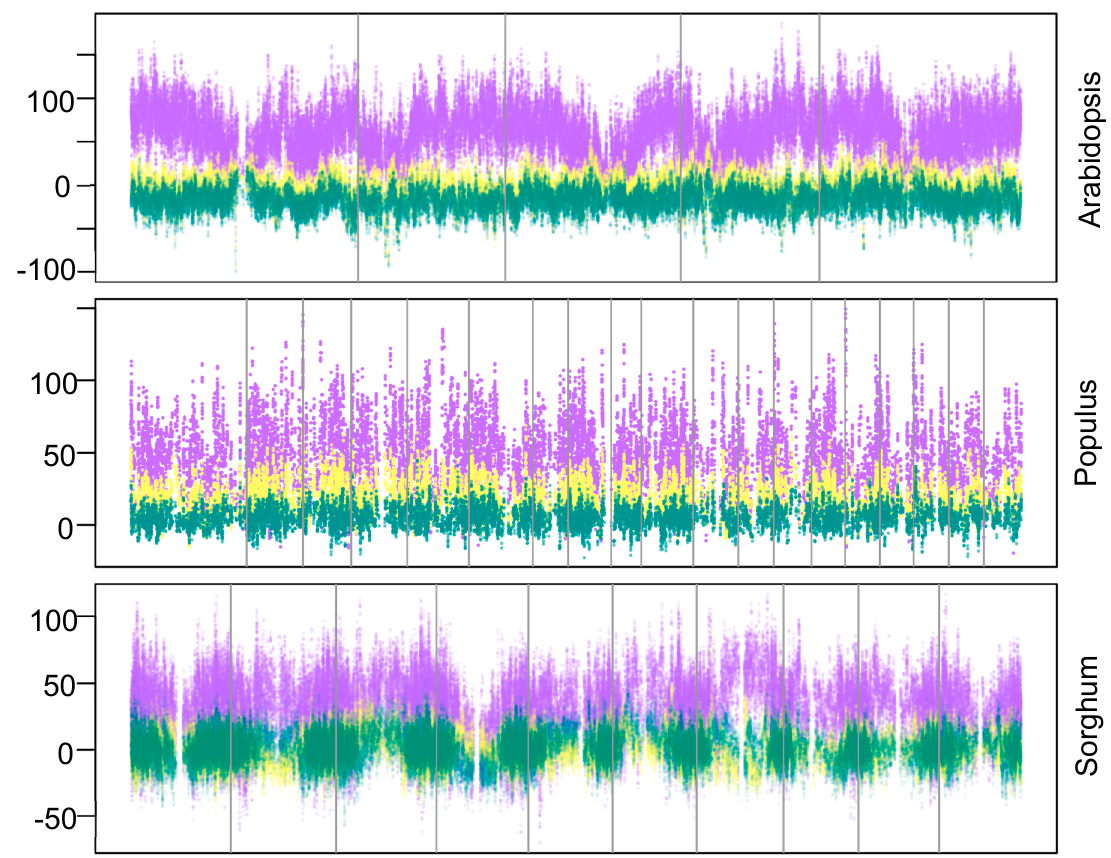
Figure 1. Relative improvement in genomewide haplotype capture achieved by using genomewide single nucleotide polymorphism (SNP) data instead of geographic or environmental data. Y-axis measures relative enrichment, where zero is the haplotypic diversity recovered in random subsets. Vertical lines mark chromosome boundaries. Points show haplotypic diversity captured at each SNP position by maximizing genomewide diversity (purple), geographic diversity (yellow), or environmental diversity (teal) in subsets. Subsets that maximize geographic or environmental diversity capture less haplotypic diversity than randomly assembled subsets across much of the genome.